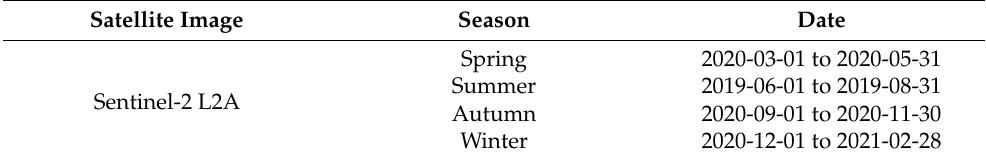
Table 1. Remote sensing image data for data composition.